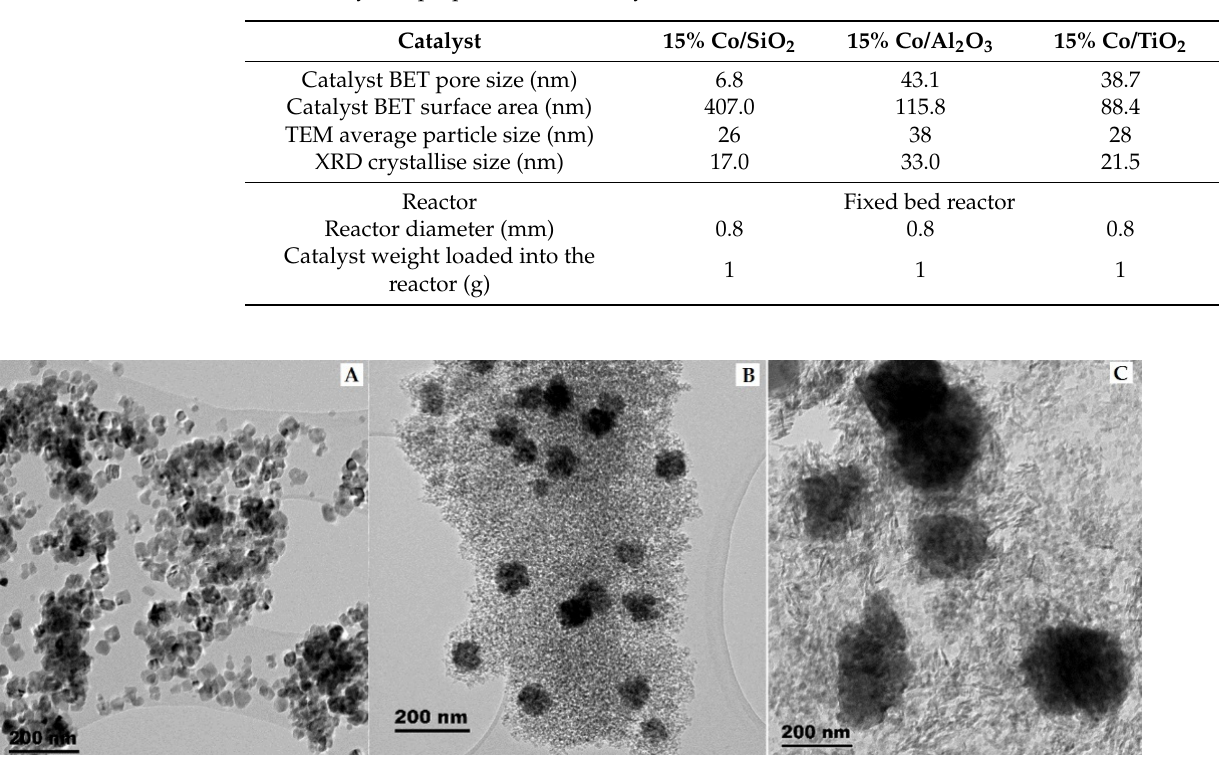
The XRD patterns for the model catalysts (Co/TiO 2 , Co/SiO 2 , Co/Al 2 O 3 ) are presented